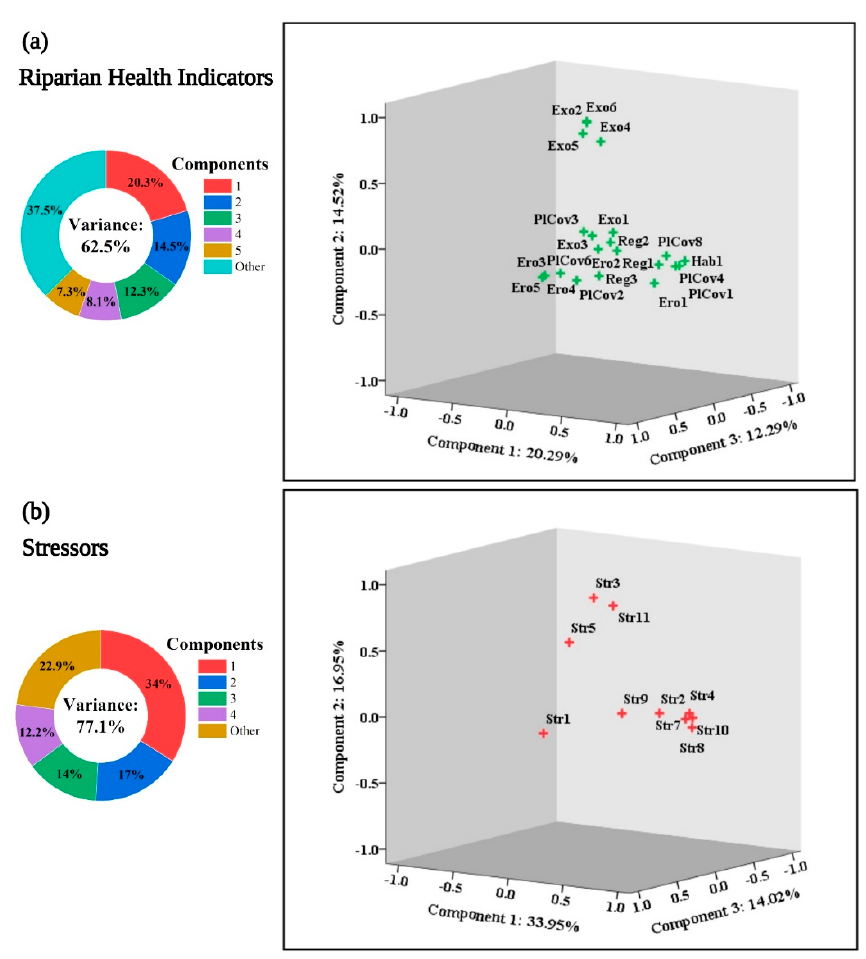
Figure 4. Factor analysis (PCA) plots of riparian health indicators ( a ) and stressors ( b ) for the upper and lower Indus basin riparian zones of the Indus River in Pakistan. The PCA factor loadings of riparian health ( a ) and stressor ( b ) indicator components explain 62.5% and 77.1% of the total variation, respectively. See more details in Figure